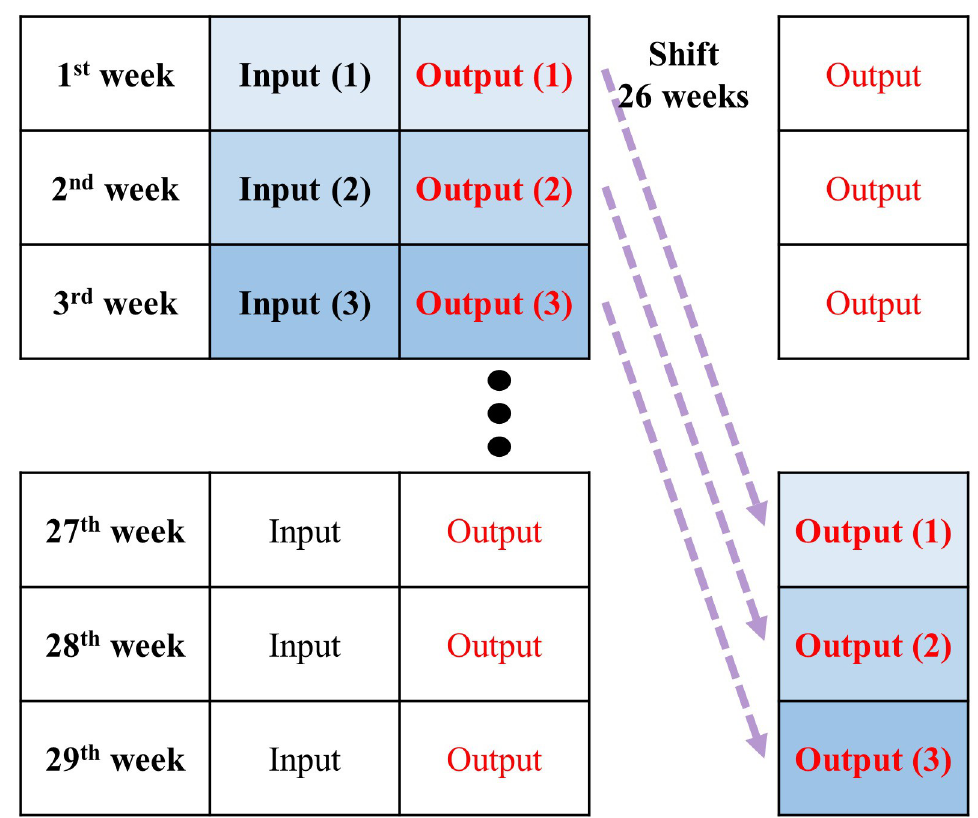
Fig 3. The explanation for forecasting seasonal influenza after 26